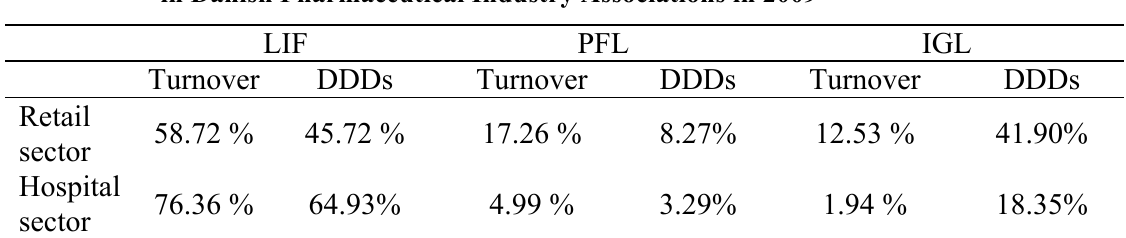
Table 2: Distribution of annual turnover and volume shares across membership in Danish Pharmaceutical Industry Associations in